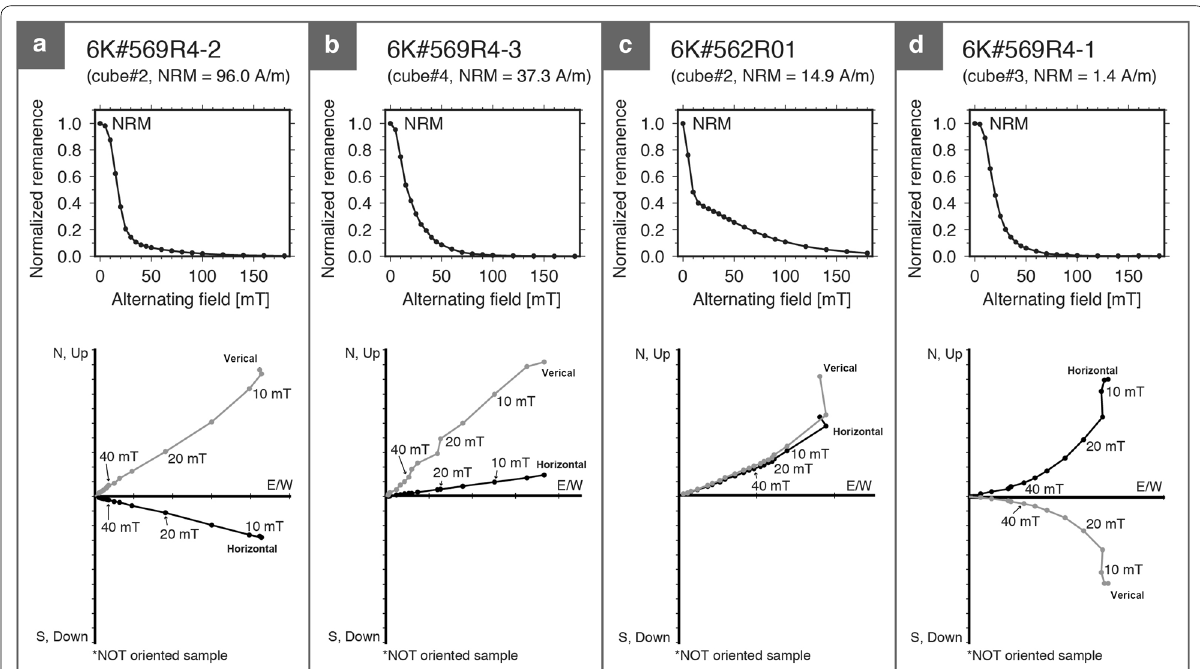
Fig. 6 Stepwise alternating field demagnetization (AFD) curves of the studied samples from the Irabu knolls of the Okinawa Trough; 6K#569R4‑2 ( a ), 6K#569R4‑3 ( b ), 6K#562R1 ( c ), and 6K#569R4‑1 ( d ). Gray and solid black circles represent projections on vertical and horizontal planes, respectively. Inclination and declination are relative because lava samples are not